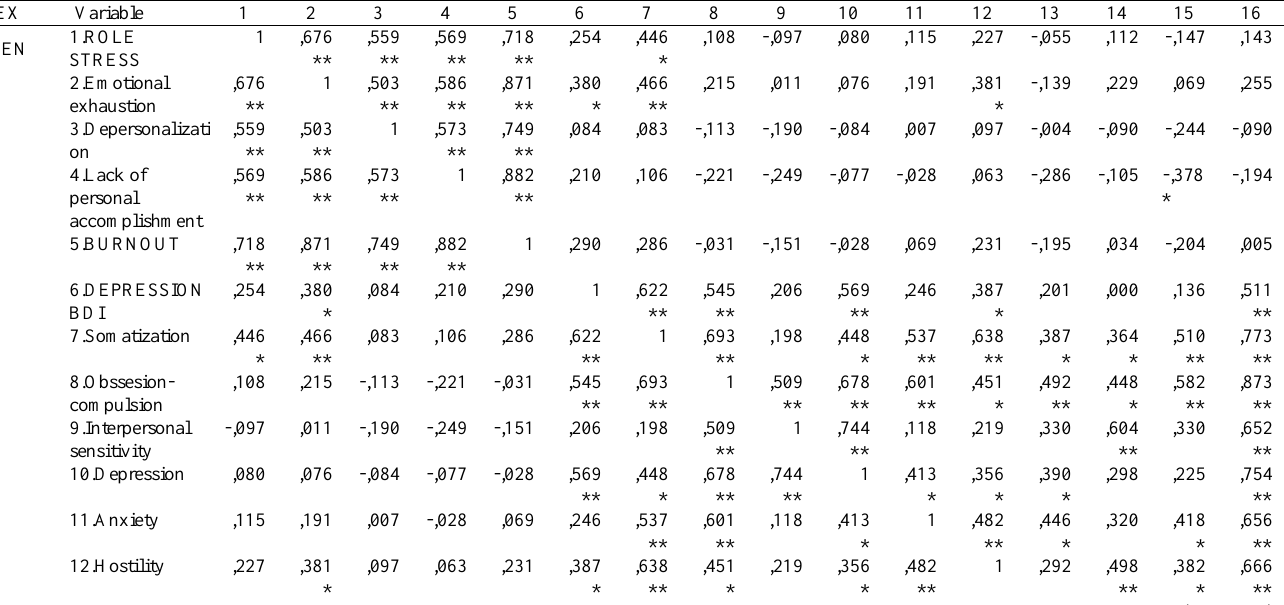
Correlations between dependent variables of the study by